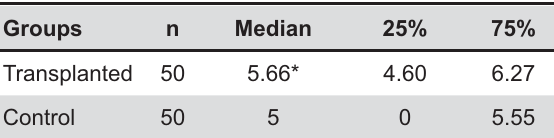
Table 2- Values of logarithm of colonies forming units per mililitre (log cfu/mL) in the studied groups